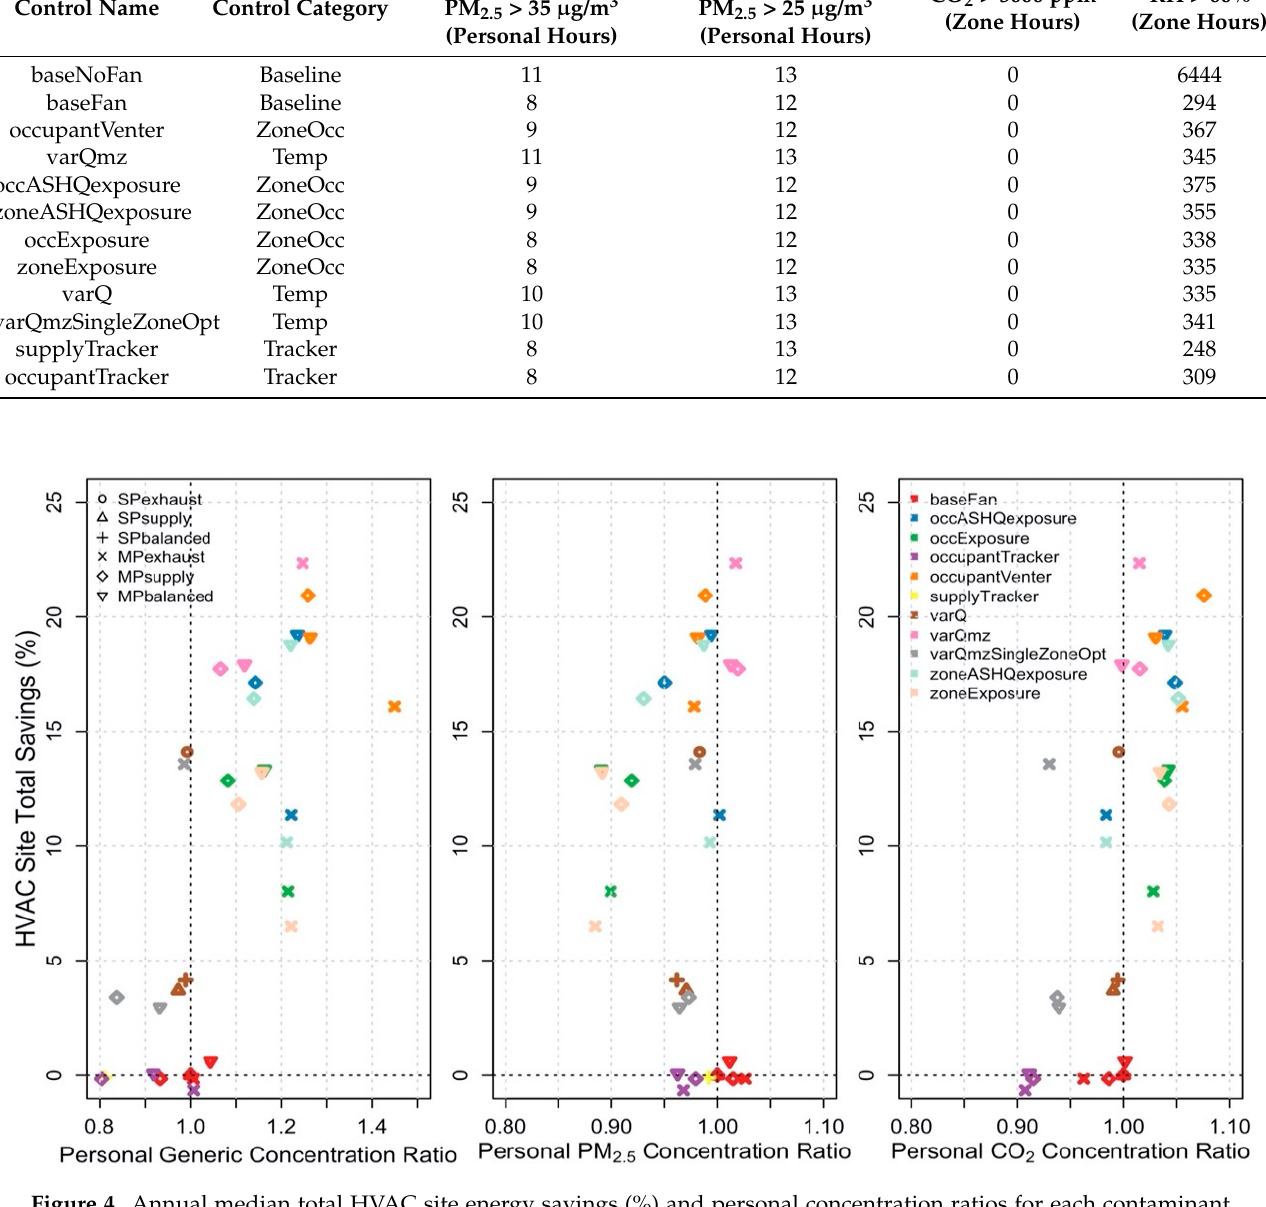
Figure 4. Annual median total HVAC site energy savings (%) and personal concentration ratios for each contaminant, control type, and fan type. Table 5. Median sum of personal- or zone-hours exceeding regulatory or design thresholds for each control strategy, including PM 2.5 , CO 2 , and relative humidity. PM 2.5 limits are based on 24-h threshold values from the U.S. EPA (35 μ g/m 3 ) and the World Health Organization (25 μ g/m 3 ). 5000 ppm CO2 is based on the OSHA Permissible Exposure Limit. 60% RH is a common design threshold for buildings.